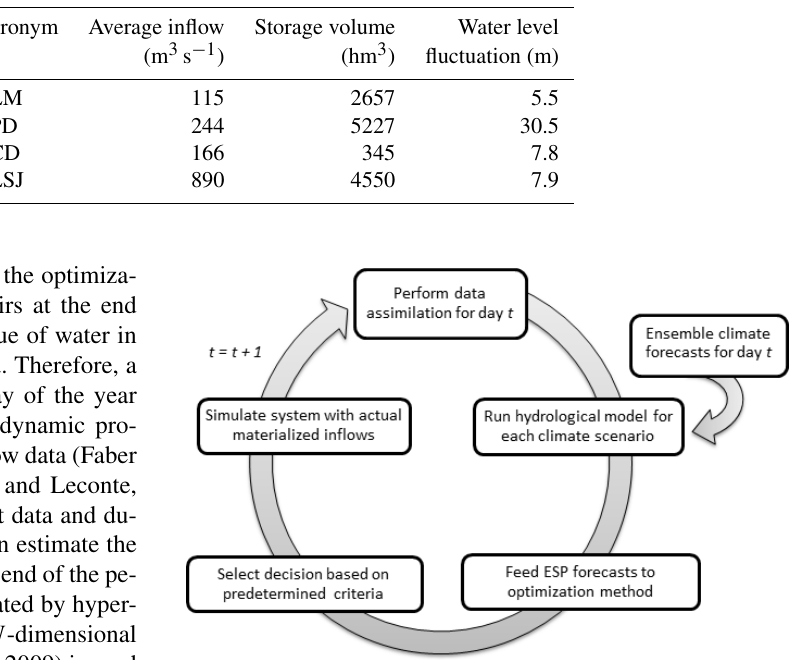
Table 2. Reservoir characteristics on the SLSJ hydroelectric complex.